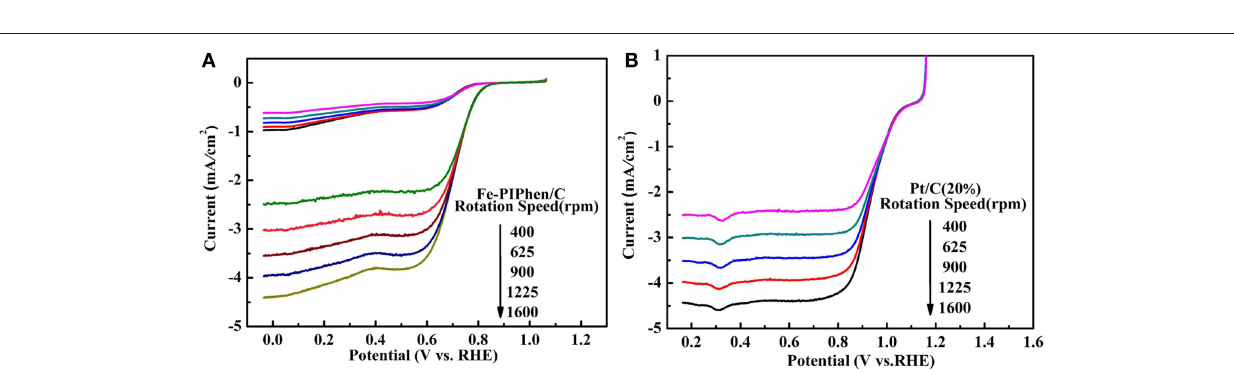
FIGURE 7 | Polarization curves of Fe-PIPhen/C (A) and Pt/C (20% content) (B) at various rotating rate in KOH solution saturated with O 2 and N 2 . Scan rate: 10